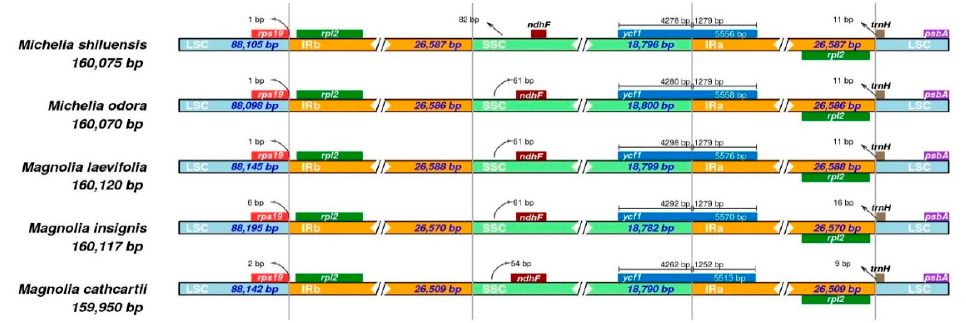
Figure 5. The four junctions of the regions in the chloroplast genomes of the five Magnoliaceae species, determined using IRscope .